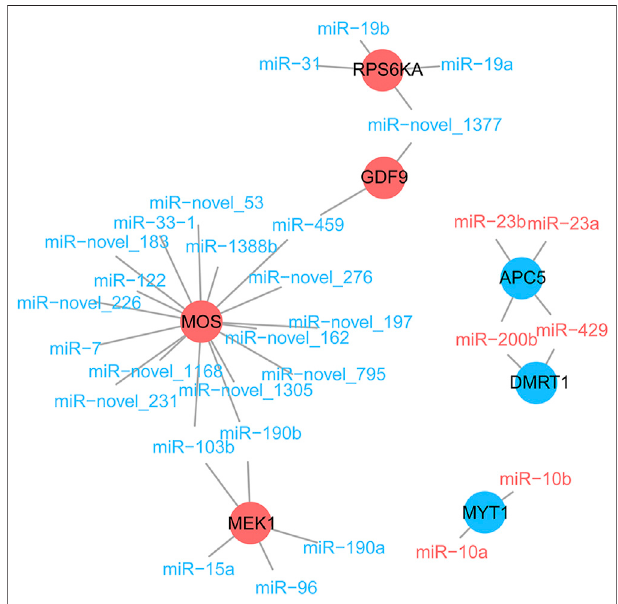
FIGURE 6 | The negative regulation of some sex-related genes by differentially expressed miRNAs. Male- and female-biased miRNA are representedbyblueandredfonts,whilemale-andfemale-biaseddifferentially expressed genes are represented by blue and red circles, respectively.